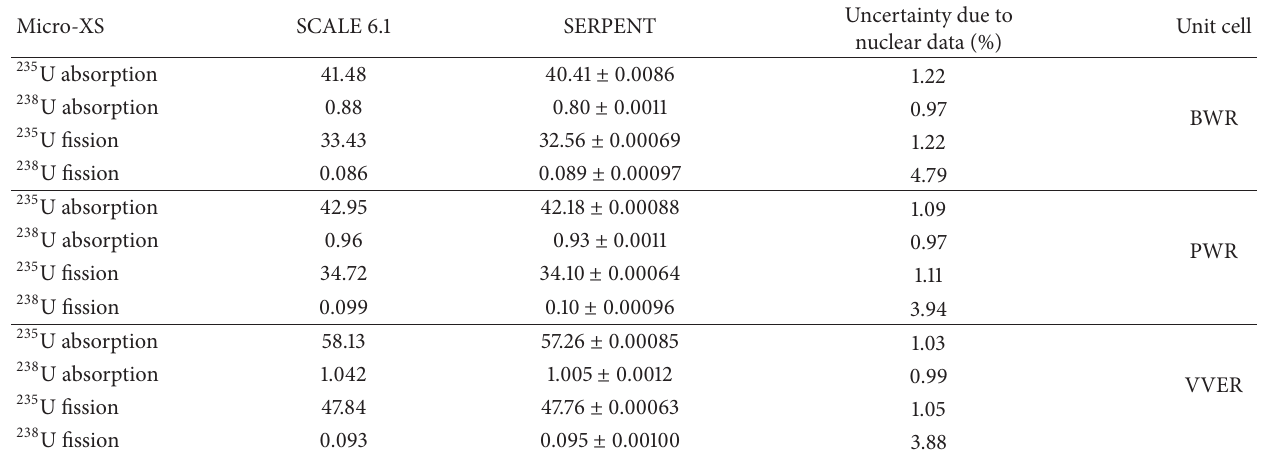
Table 6: Phase I-1 Exercises.